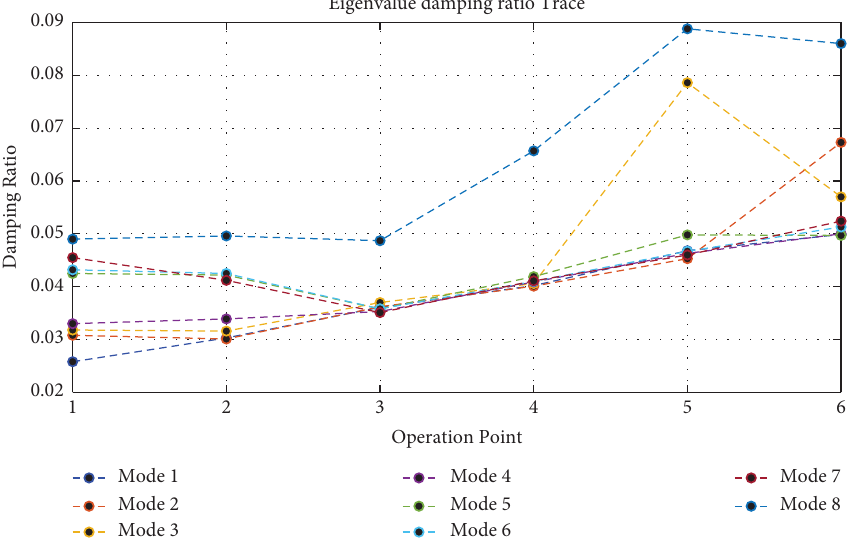
Figure 6: Damping ratio of critical modes of the system at diferent operating points for IEEE 39-bus